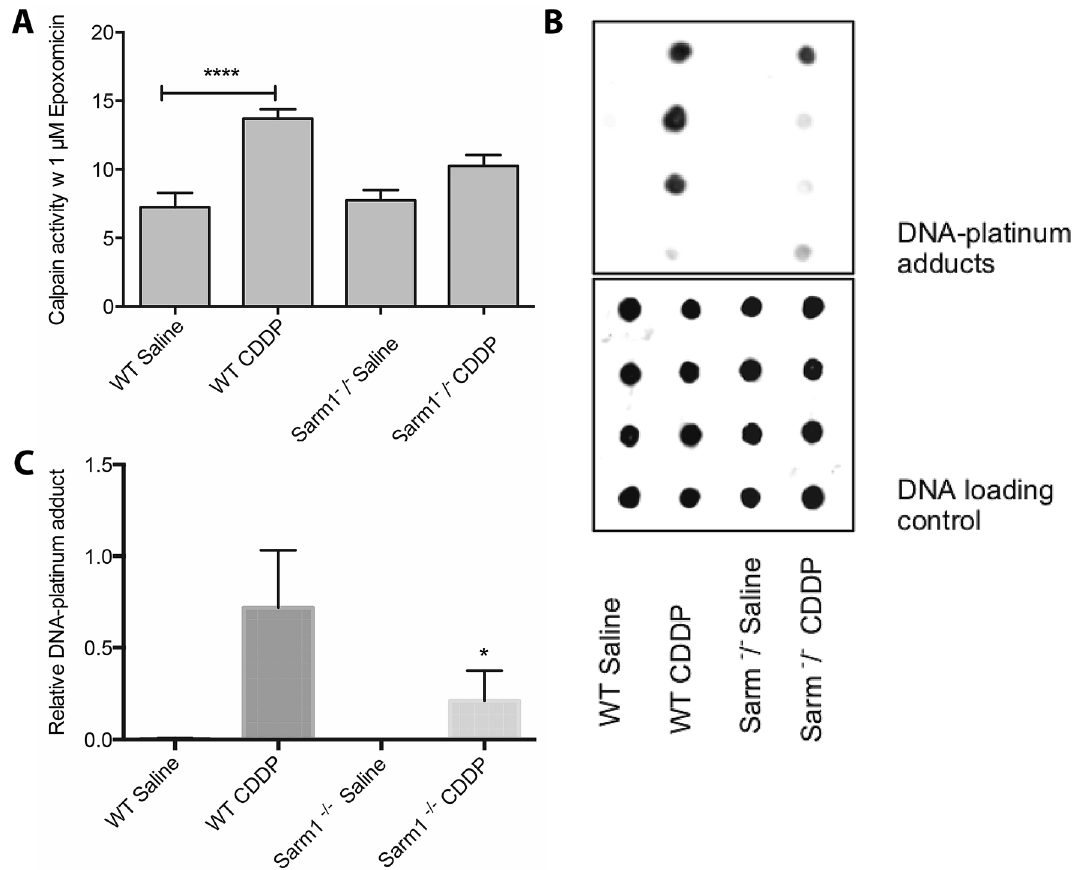
Figure 8. Calpain activation ( A ) and DNA-platinum adduct formation ( B , C ) in WT and Sarm1 −/− mice treated with CDDP (Images in B are uncropped dot blots of representative 4 samples from each group; quantitation in panels A and C are from n = 5 per WT mice and n = 7 per Sarm 1 −/− mice, * p < 0.05, **** p < 0.001, one-way ANOVA with multiple comparisons, error bars denote